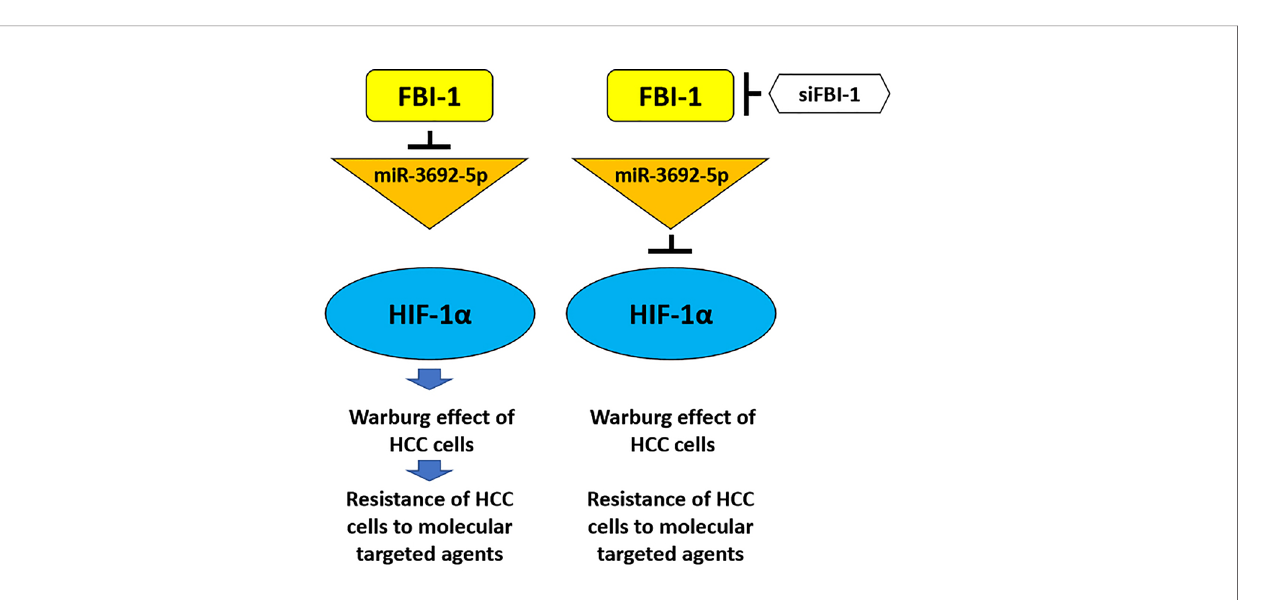
FIGURE 8 | The proposal model of the present work. FBI-1 can downregulate the expression level of miR-3692-5p, thereby causing the upregulation of HIF-1a expression and fi nally downregulating the sensitivity of HCC cells to molecular targeted drugs by inducing the Warburg effect of HCC cells. The siRNA of FBI-1 is used to inhibit the expression of FBI-1. At this time, the expression level of miR-3692-5p is upregulated, and then by inhibiting the expression of HIF-1 a and inhibiting the Warburg effect of HCC cells, it reverses the resistance of HCC cells to molecular targeted drugs.